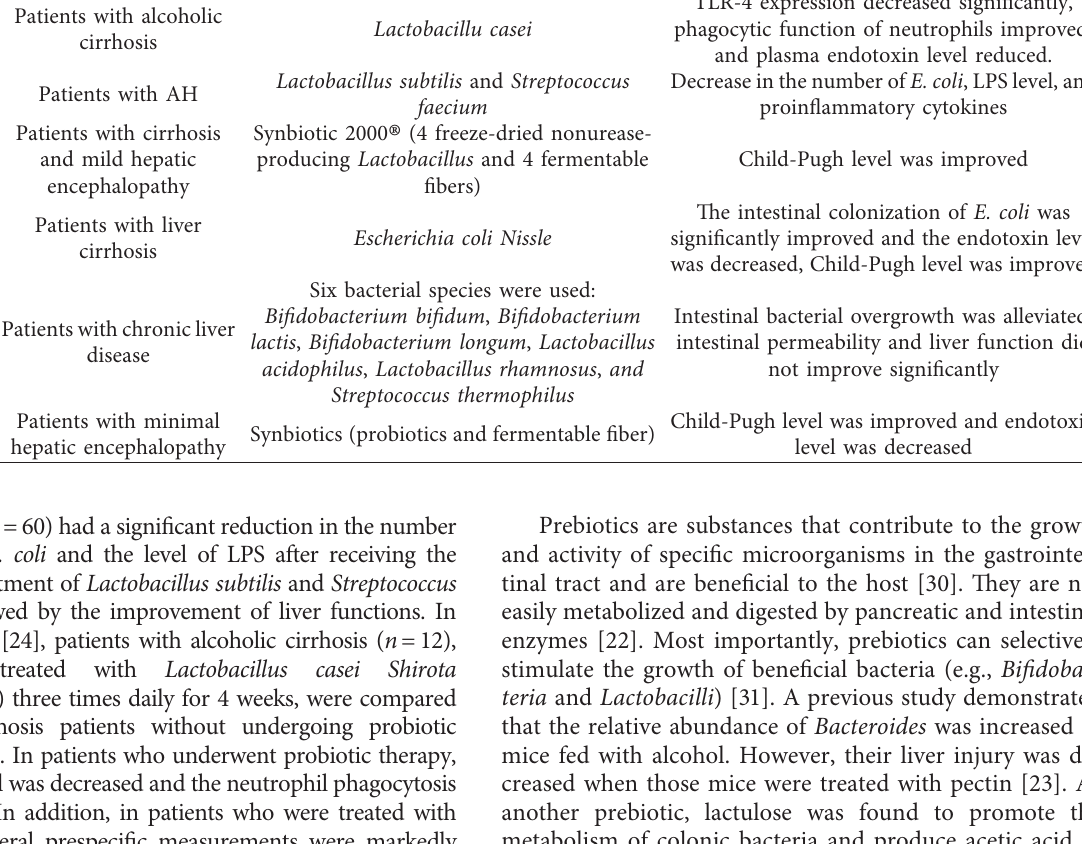
Table 2: Human experimental studies on the treatment of ALD with probiotics, prebiotics, and synbiotics.